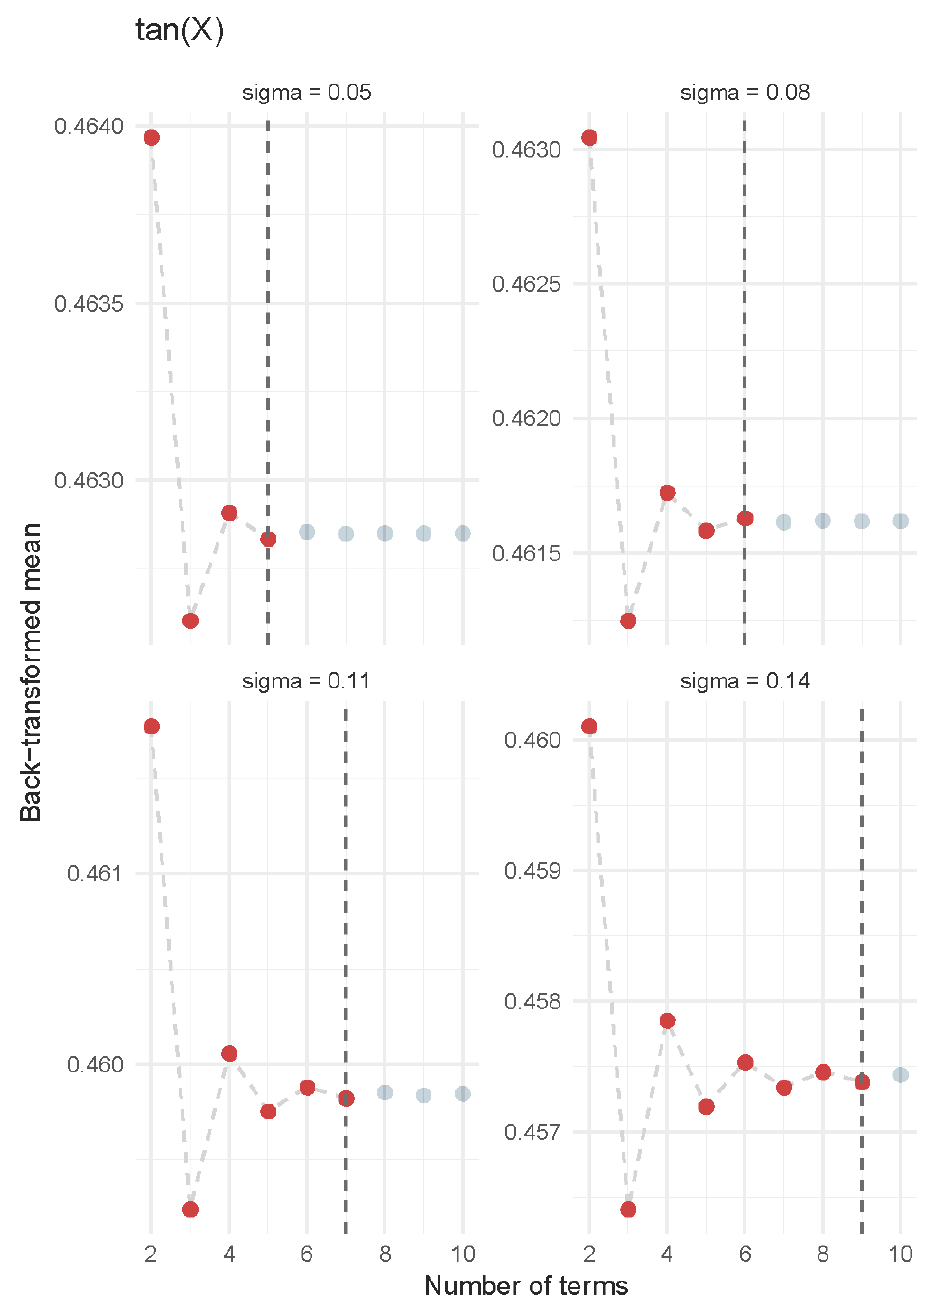
Figure 3. Convergence of the tangent transformation according to the number of terms in the Taylor series expansion. The vertical dotted line identifies the number of terms for which two consecutive differences between Taylor series estimates are less than the preset value of the order of 10 − 5 .